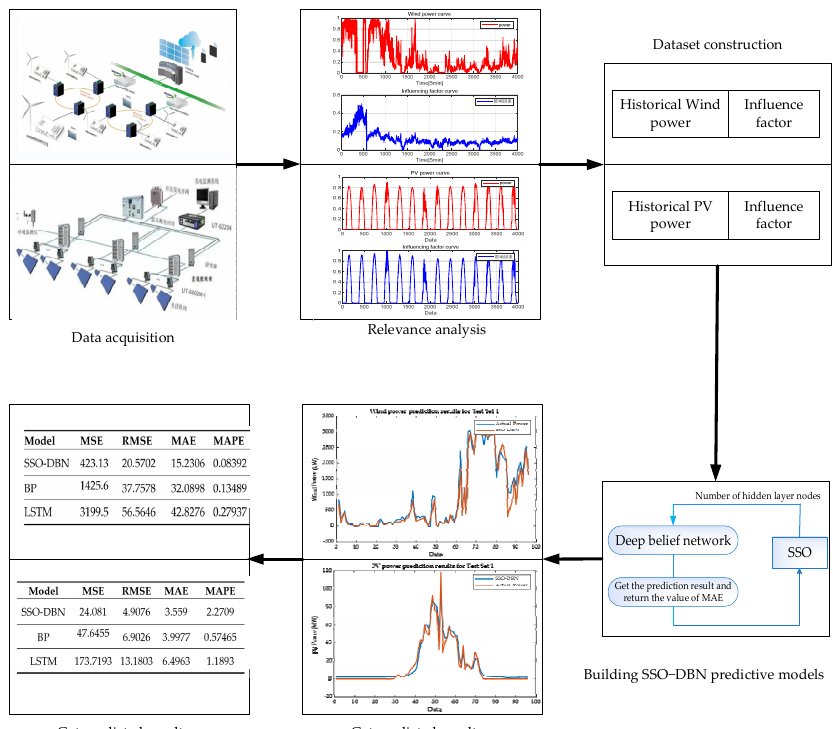
Figure 6. Overall flowchart of the renewable energy power prediction.